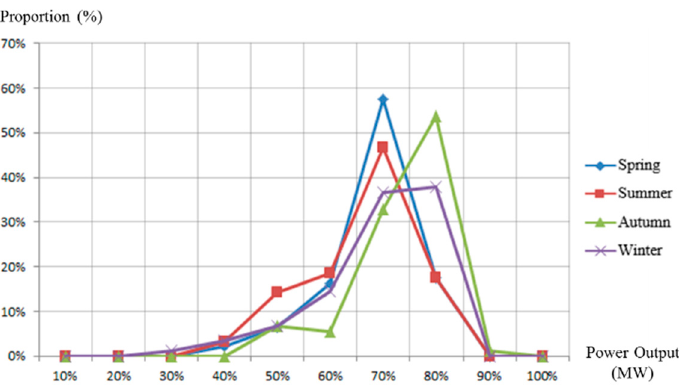
Figure 2. Probability distribution curve of PV power output in 2008 of Qinghai Province PV stations.